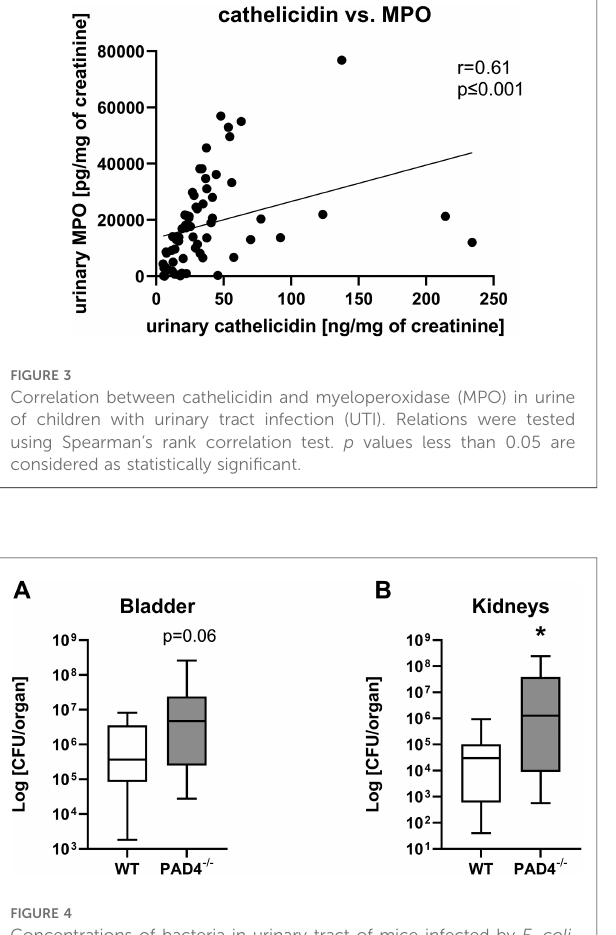
FIGURE 4 Concentrations of bacteria in urinary tract of mice infected by E. coli